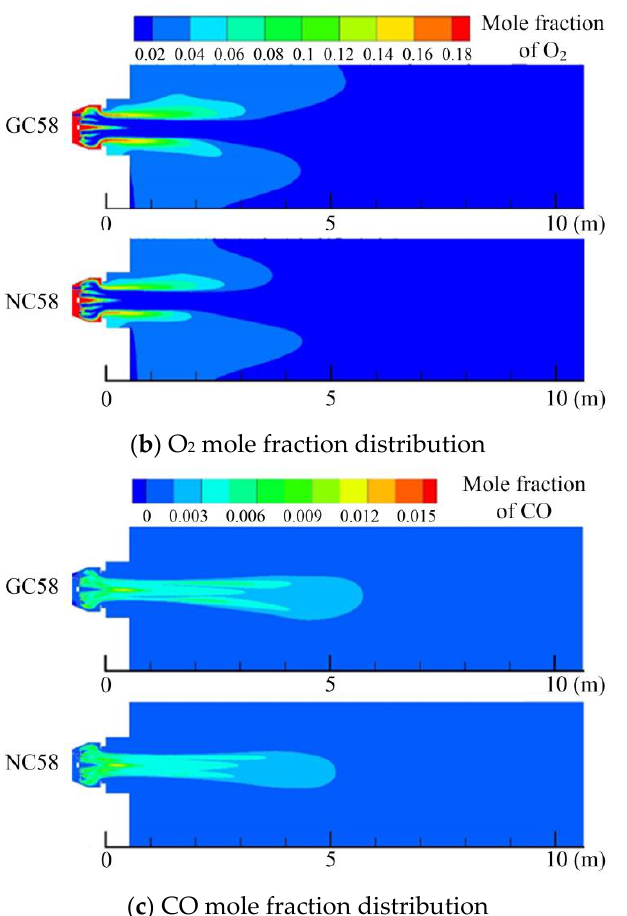
Figure 13. The distribution of ( a ) Temperature ( b ) Mole fraction of O 2 and ( c ) CO for NC58 compared to GC58 at z = 0.